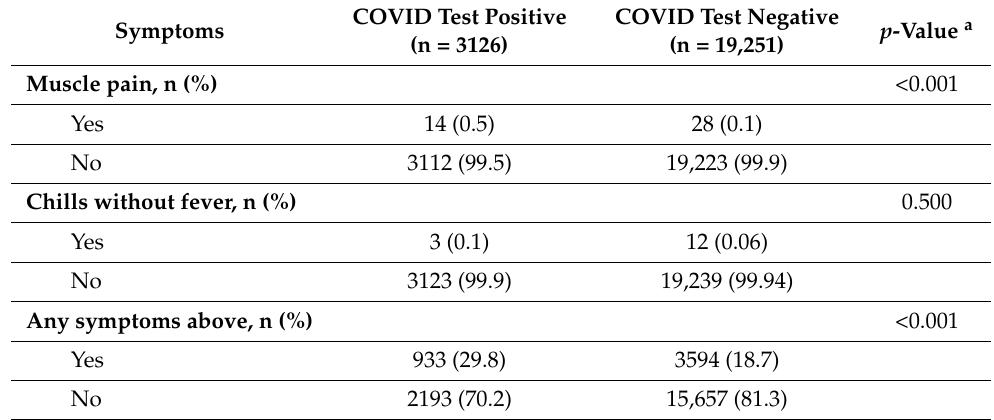
a Pearson chi-square test.